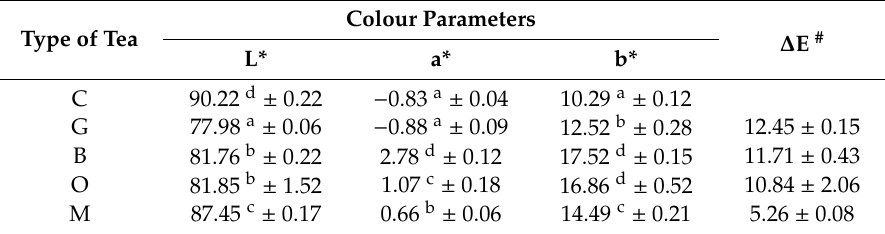
Table 2. Colour parameters and the total colour di ff erence parameter of yogurts obtained without